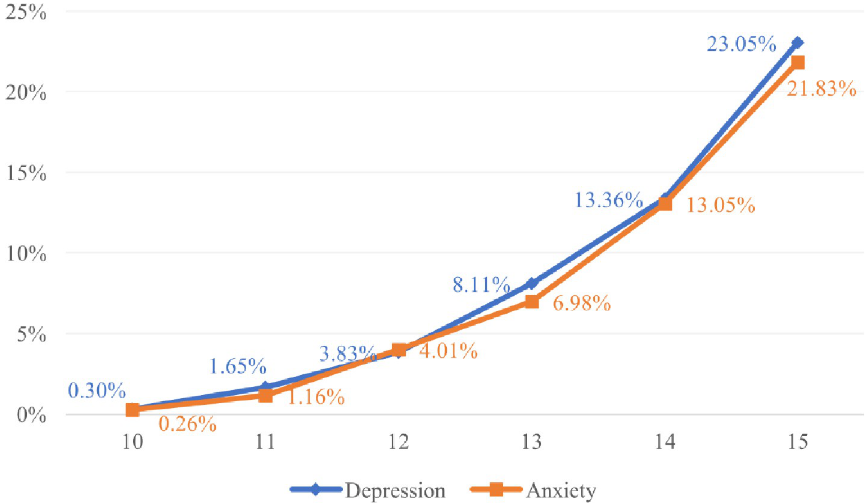
Fig 3. Distribution of depression and anxiety with participants’ age (from 10 to 15